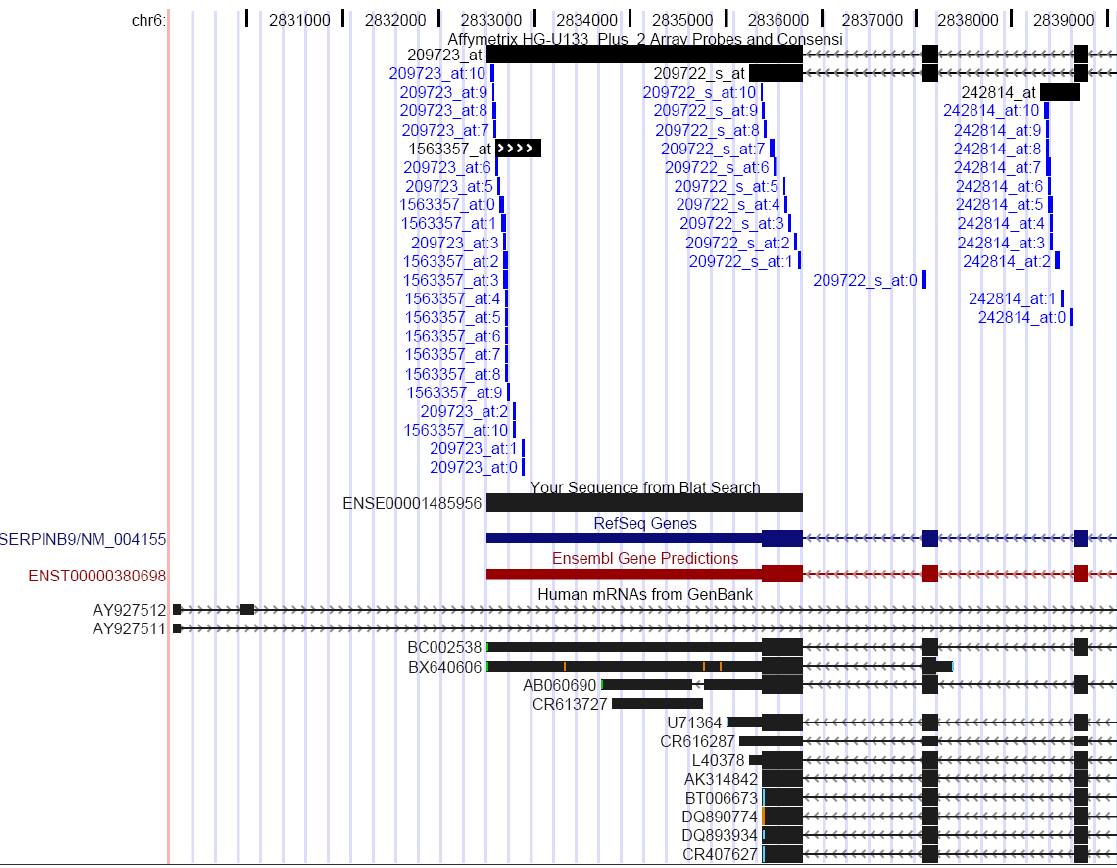
Figure S6. UCSC screen shot for